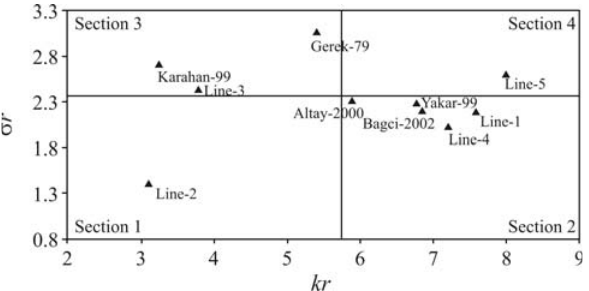
Figure 5 - Plot of the rank standard deviation ( σ r ) against the rank ( kr ) for 10 bread wheat genotypes over